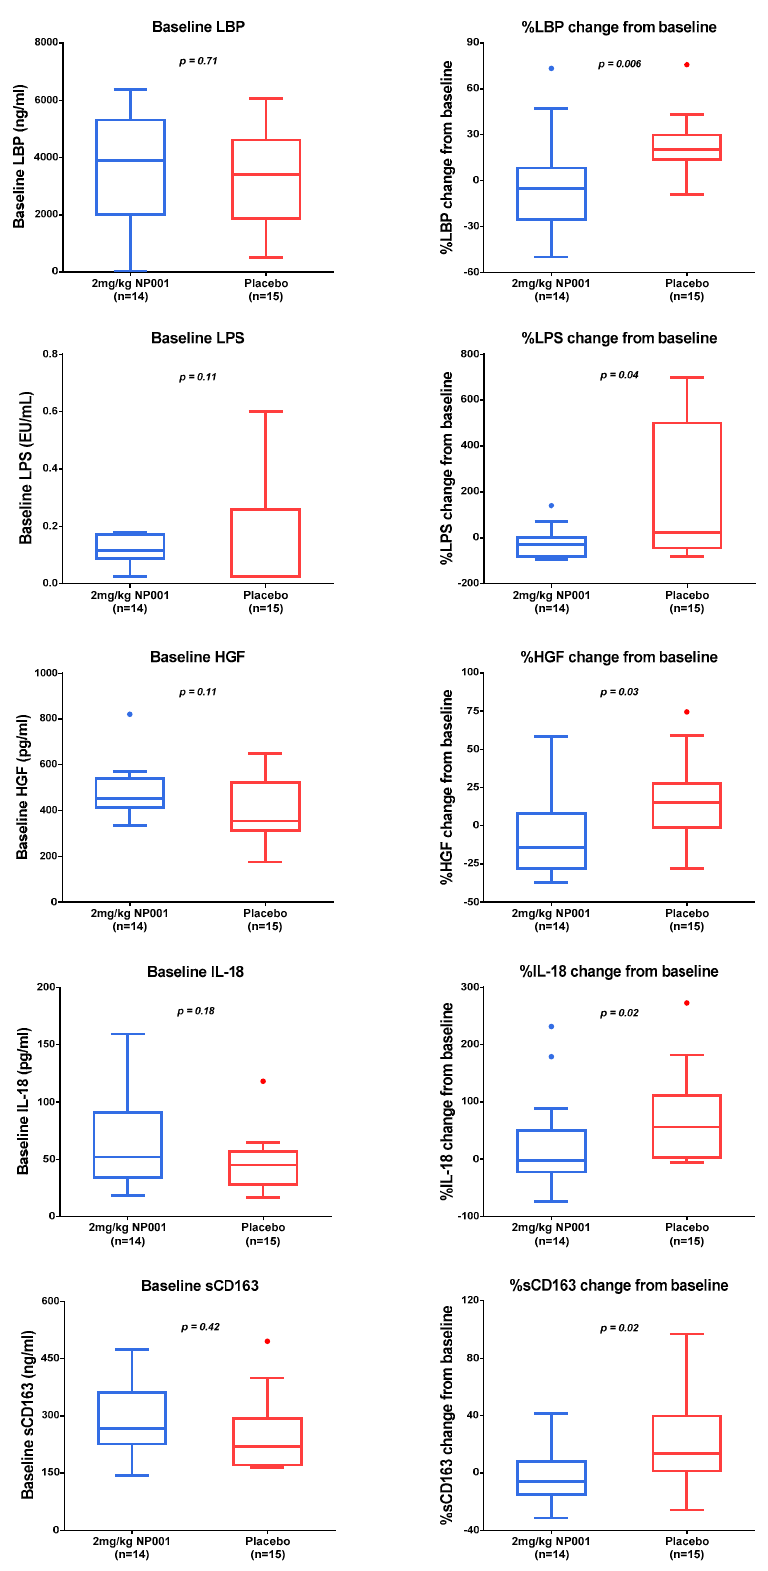
Figure 4. NP001-associated decrease in plasma biomarkers. Plasma biomarker levels at baseline (left column) and % change from baseline after 6 months (right column) in participants with plasma CRP > 1.13 mg/L in the phase 2A trial. Compared to the placebo group ( n = 15), the